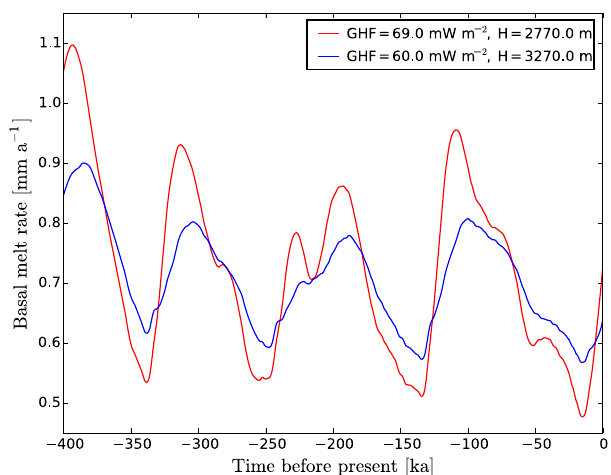
Figure 8. Changes in the basal melt rate, depending on the ice thick- ness and on the